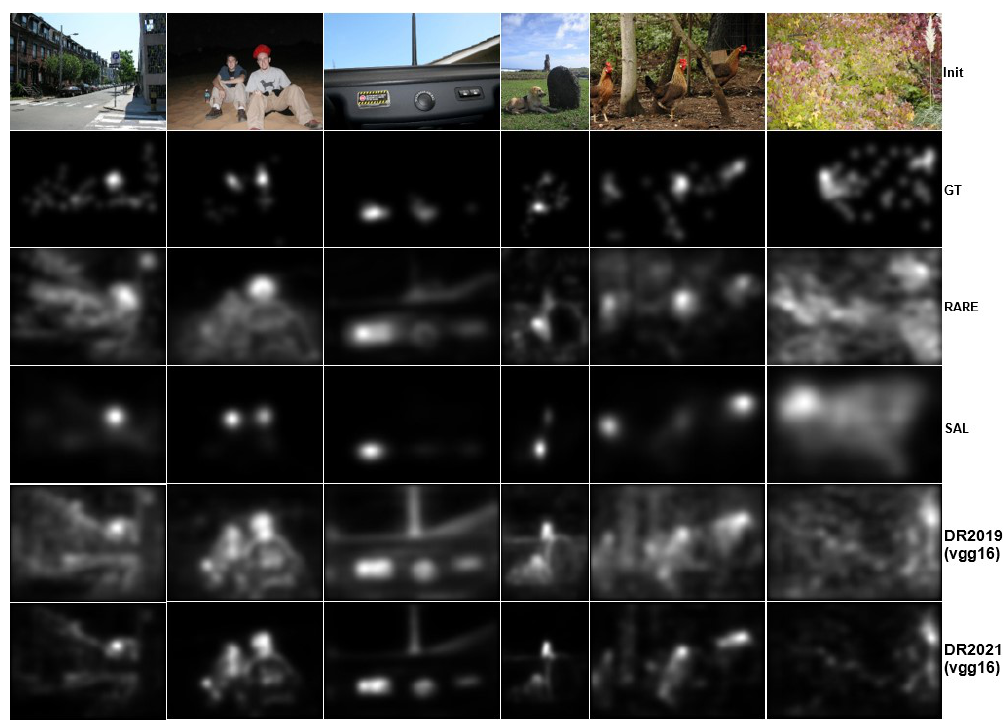
Figure 9. Selected samples MIT1003 dataset. From top to down: initial, ground truth, RARE2012, SALICON, DR2019, DR2021.